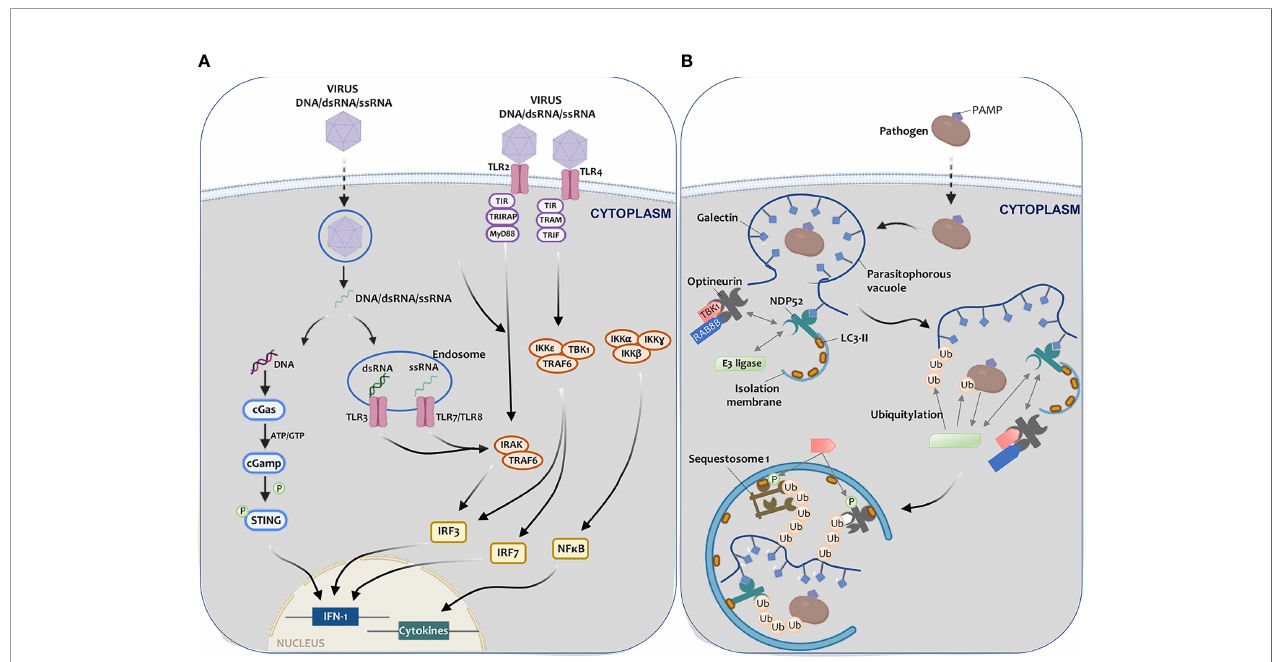
FIGURE 4 | Autophagy-mediated elimination of pathogens. (A) Once a virus enters a cell, (I) viral DNA may be exposed in the cytoplasm, leading to cGAS-STING pathway activation and IFN-I expression, thus triggering the antiviral defense; or (II) viral RNA (endosome) can be recognized by TLR3 (dsRNA) and by TLR7 or TLR8 (ssRNA), triggering IRAK and TRAF6, which leads to IFN-I synthesis. Virus recognition by TLR2 or TLR4 may also trigger the cascade that leads to IFN-I (IRF3, IRF7, or NF-kB) and pro-in fl ammatory cytokine activation transcription factors. (B) Once pathogens enter the cell, a parasitophorous vacuole with glycosylated molecules starts enclose them. Galectins present in this vacuole bind to NDP52, which interacts directly with E3 ligase LRSAM1 and indirectly with TBK1. TBK1 interacts with optineurin. NDP52 binds to LC3-II, resulting in xenophagy activation. LRSAM1 polymerize ubiquitin at different targets that are yet to be identi fi ed. This hypothetical model includes the pathogen and the parasitophorous vesicle as targets. NDP52 recognizes the ubiquitin tags, optineurin, and sequestosome-I. TBK1 phosphorylates optineurin and sequestosome (I) After these steps, the autophagic isolation membrane elongates to capture the pathogen to degrade